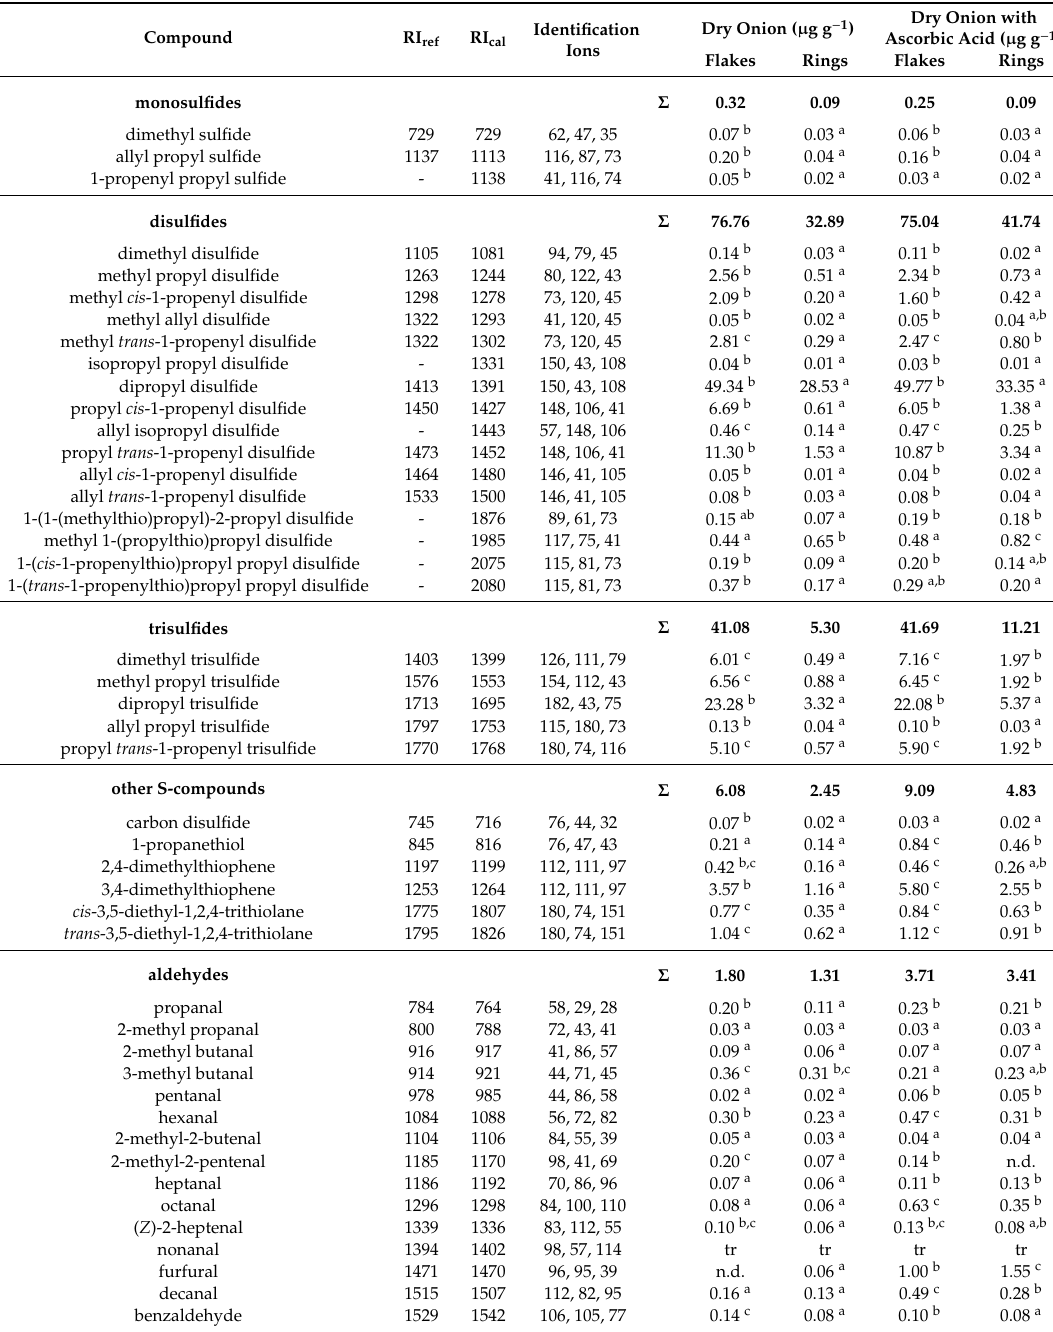
Table 1. Relative concentration ( µ g g − 1 based on the relative quantitation using internal standard, of volatile organic compounds detected acid by HS-SPME-GC-MS in the di ff erent onion samples in the absence and presence of ascorbic acid. Data are the mean of three determinations. Retention Indices (RI cal ): Non-isothermal Kovats retention indices from temperature-programming, using the definition of Van den Dool and Kratz, 1963 [19]. Retention Indices (RI ref ): Non-isothermal Kovats retention indices from temperature-programming from Chemistry WebBook. Not dectected (n.d.). traces (tr). For each compound, di ff erent letters (a, b, c) indicate significant di ff erences at p < 0.05 by Fisher’s Least Significant Di ff erence (LSD)